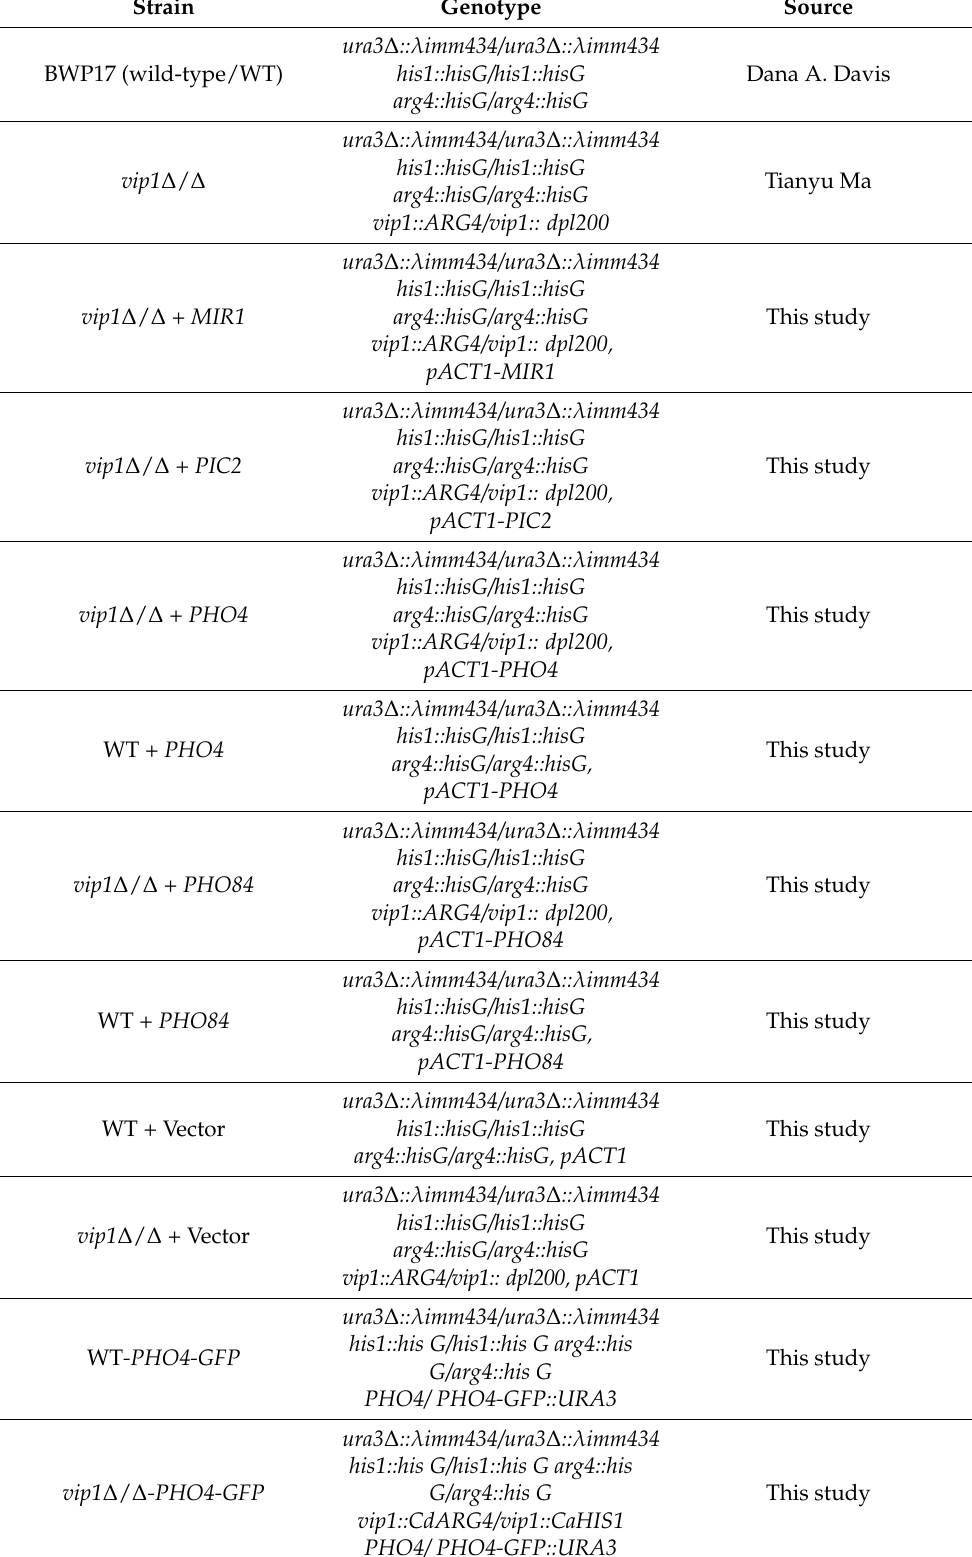
Table 1. Strains. Strain